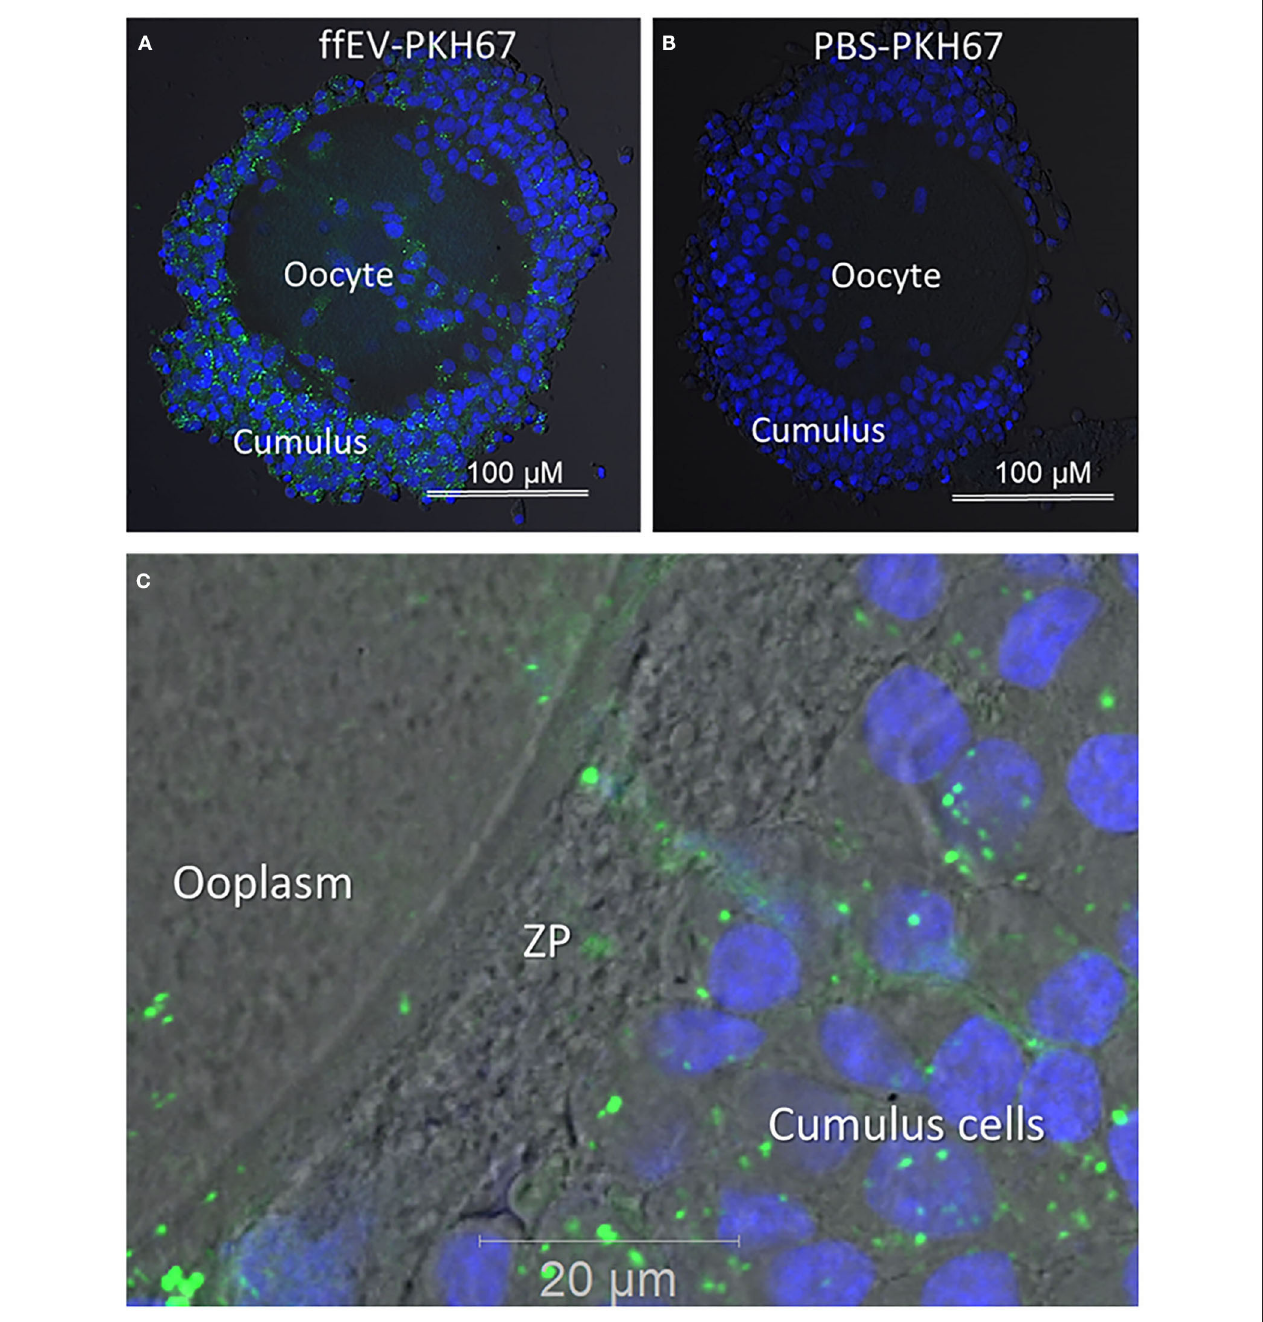
FIGURE 2 | Uptake of follicular fluid extracellular vesicles (ffEVs) by cumulus–oocyte complexes during in vitro maturation is shown. (A) Representative confocal microscopy images of COCs after 24h IVM in the presence of 50 µ g/ml of labeled exosomes, ffEVs-PKH67, or (B) a similar volume of a control PBS-PKH67 preparation. (C) Fluorescent ffEVs were observed in the cytoplasm of cumulus cells, the zona pellucida (ZP), and ooplasm.